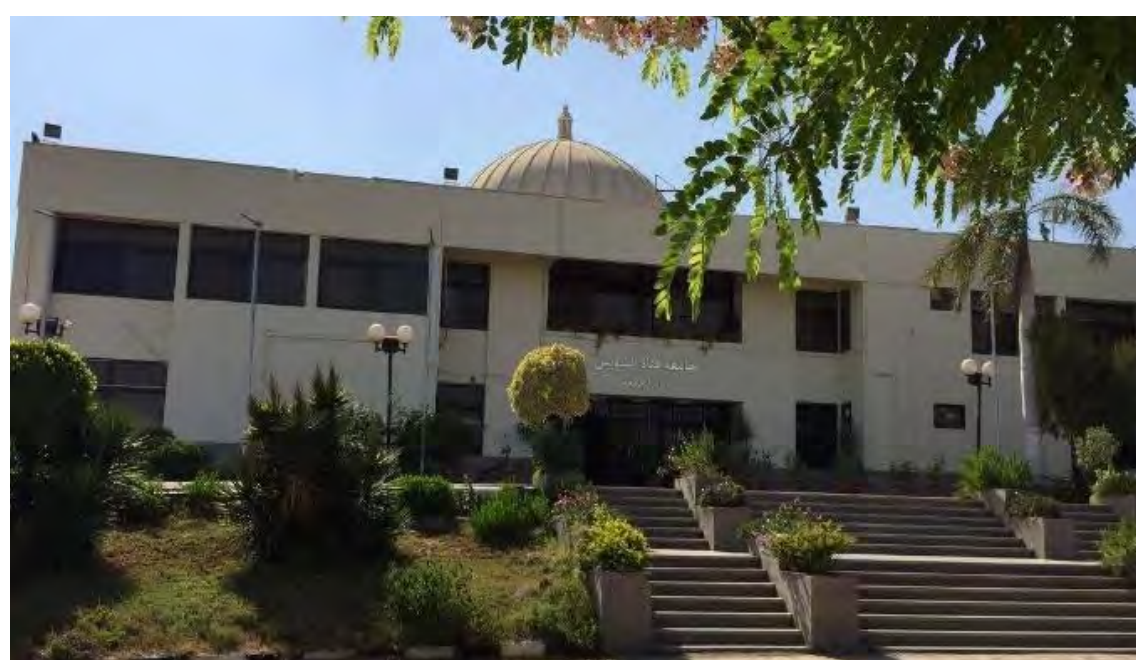
Figure 6. main entrance east